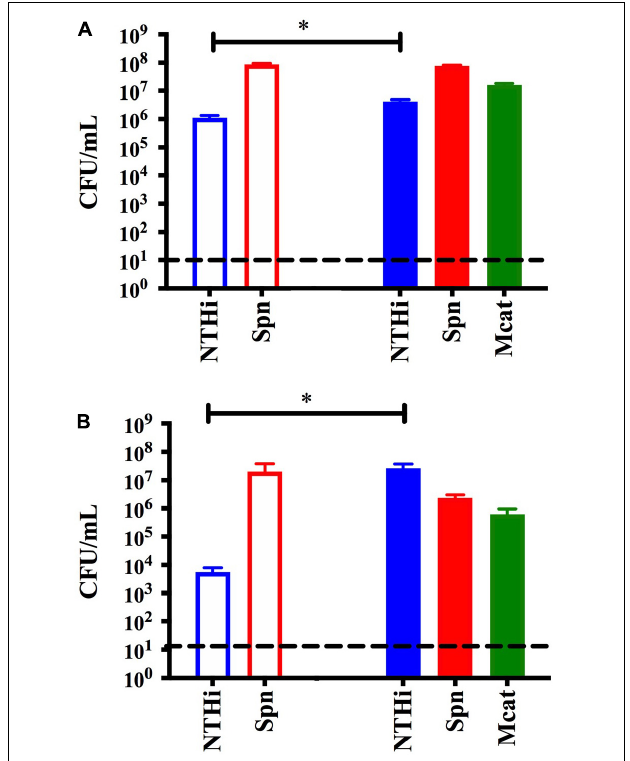
FIGURE 4 | Transwell assay to assess protection without cell to cell contact. Dual species S. pneumoniae EF3030 (Spn) and NTHi 86-028 NP (NTHi) biofilms were seeded in 24-well plates on a fixed H292 cell monolayer. To the filter inserts, approximately 10 5 CFU per mL M. catarrhalis 7169 (solid) or CDM (open) was added. Protection was assessed at (A) 24 h and (B) 48 h where bars represent the mean and SD of three independent assays with a minimum of four technical replicates. P -value of 0.05 was considered significant and indicated by asterisk ( ∗ ).